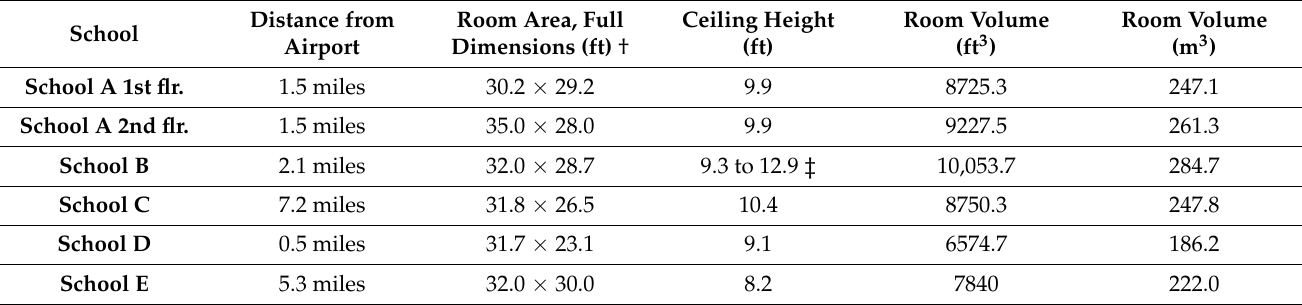
Table 1. School classroom dimension and volume.